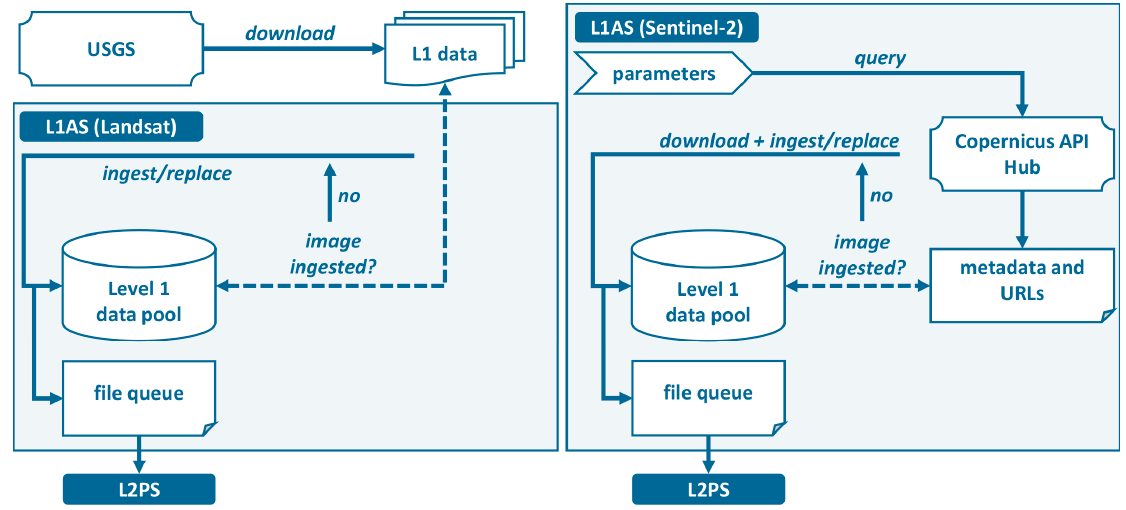
Figure 3. FORCE Level 1 Archiving Suite (L1AS) workflow.